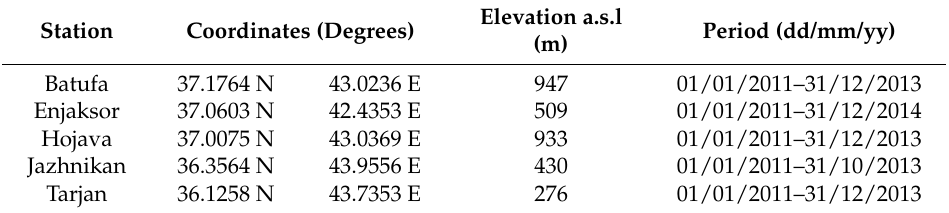
Table 2. Tower stations with hourly data of Air Temperature (AT), Relative Humidity (RH) and Wind Speed (WS) and GHI at ground measurements with GHI of two Satellite-Derived Datasets (SDDs) and with calculated clear sky (Cs) and top-of-atmosphere (TOA) irradiance.